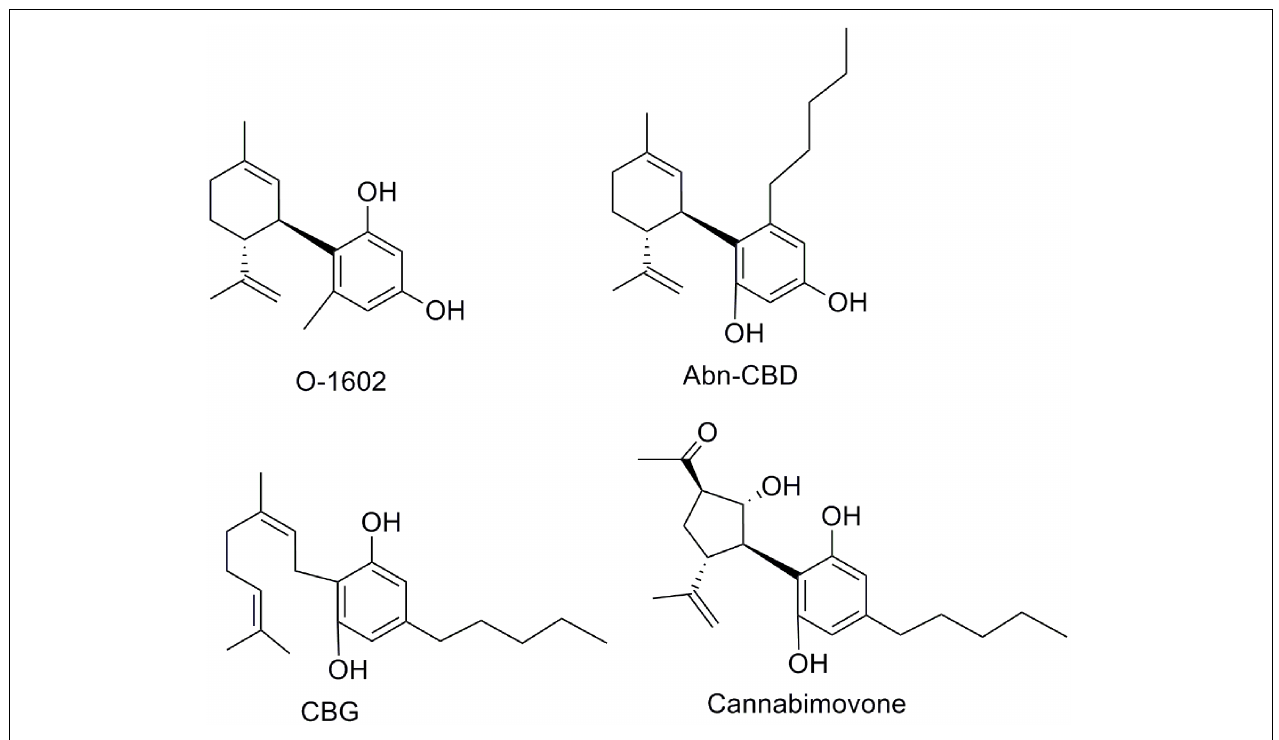
FIGURE 14 | Miscellaneous CBD